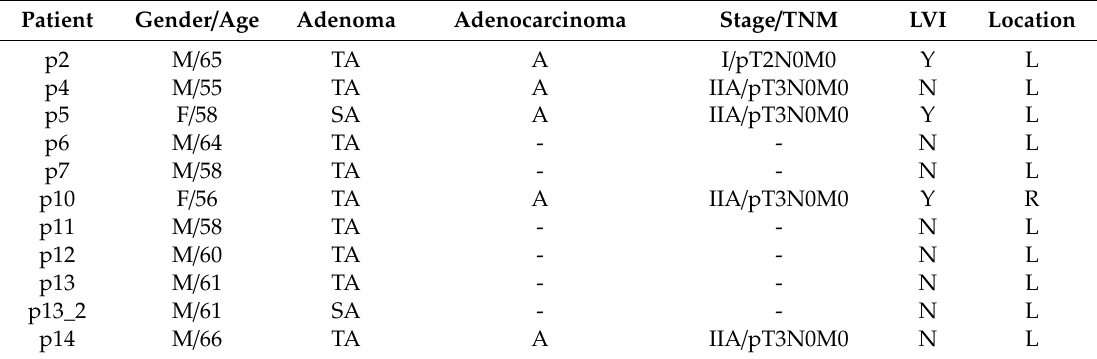
Table 2. The clinical information of colorectal adenomatous and CRC